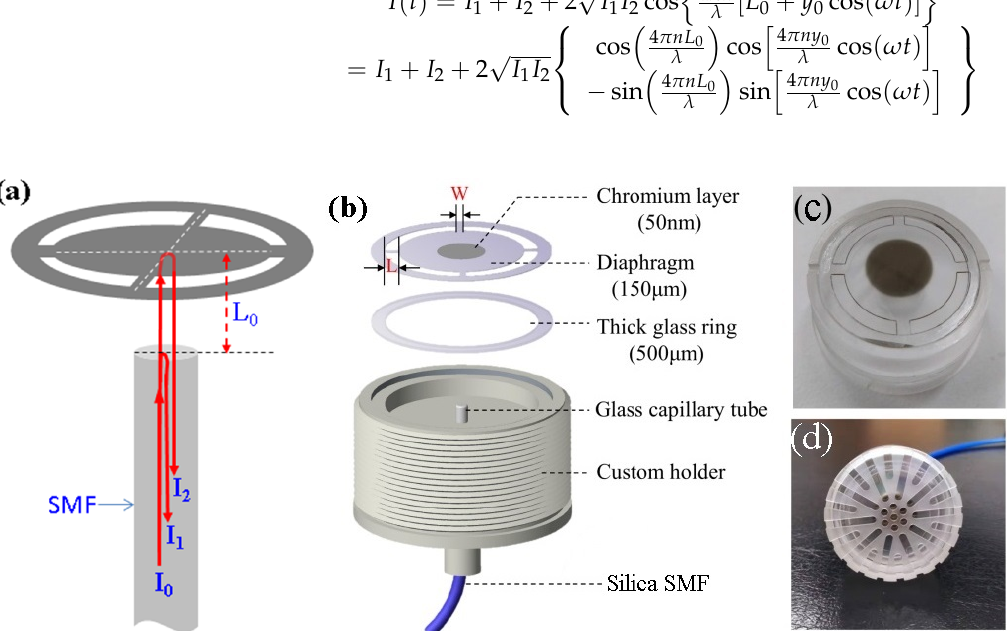
Figure 3. ( a ) Schematic diagram of the Fabry - Perot interferometric principle; ( b ) schematic diagram of the components designed for assembling the fiber-optic microphone head; ( c ) photograph of the wheel-shaped glass diaphragm installed on the holder; ( d ) the prepared microphone head with a protective cap.